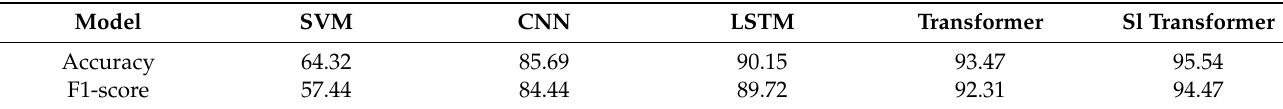
Table 2. The table of accuracy of the Sl transformer and compared